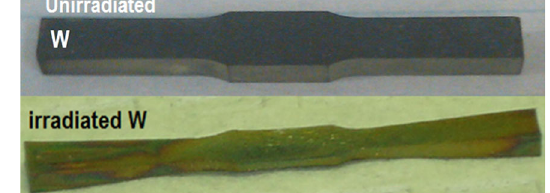
compression.FIG. 23. Observed erosion of tungsten CTE sample